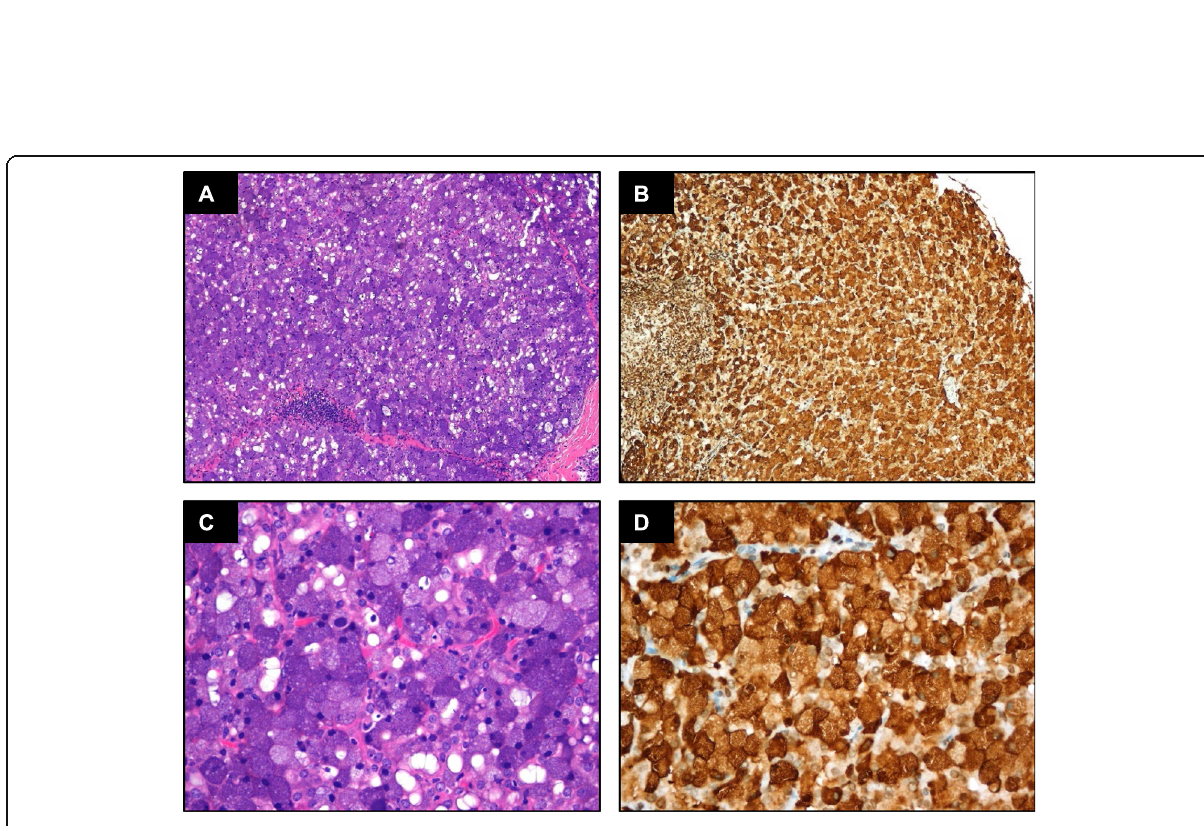
Fig. 2 ( A ) Histomorphology of a classic ACC. ( B ) The neoplastic cells express LMO2 in high levels. ( C - D ) Higher power